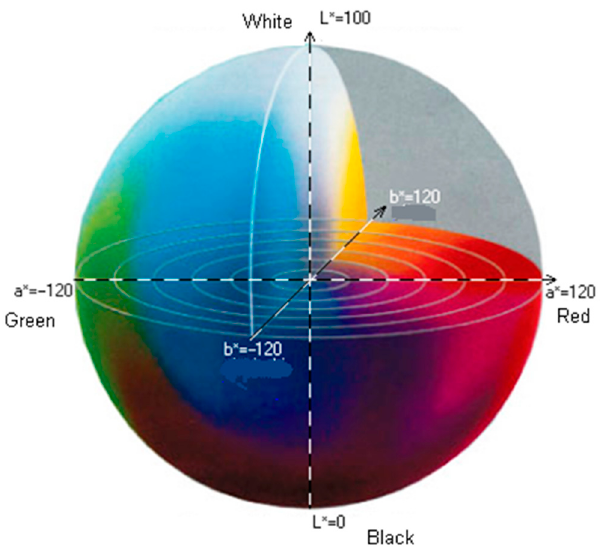
Figure 1. Colors in the CIEL Lab system. Source: Own study based on Marsza ł ek [5].